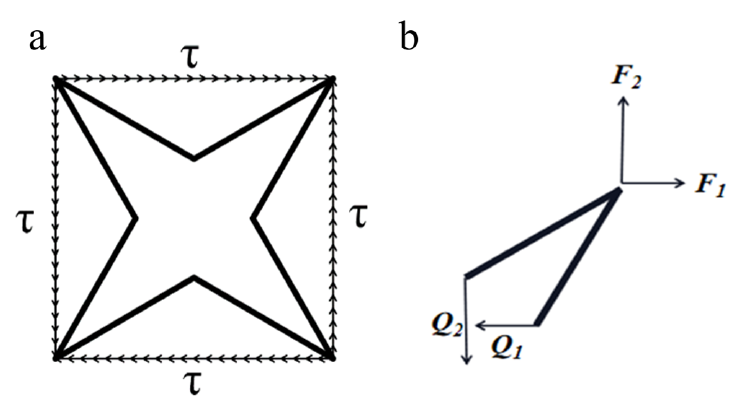
Figure 4. The four-pointed star honeycomb in pure shear: ( a ) unit cell subjected to pure shear stress, ( b ) the loads and displacements of the quarter unit cell caused by shear stress.